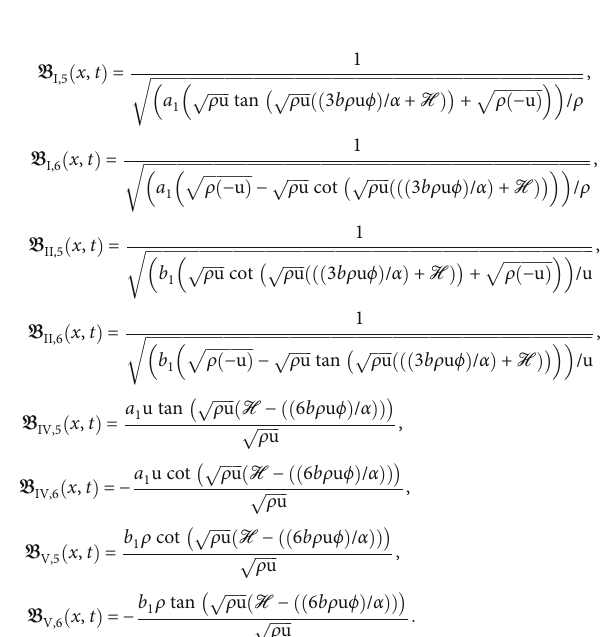
ffiffiffiffiffiffiffiffiffiffiffiffi (cid:3) / ρ + ρ − u ð Þ